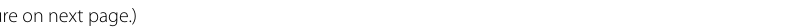
figure on next Fig. 6 Duplication of Chr2-6 and Chr11-2 regions and checking transformants by colony PCR. Upper part of a , b represents 2 duplication modules (One module synthesized from the plasmid pSJ23 contained URA3 and another module synthesized from the plasmid p3121 contained CEN4 as a centromere) were introduced into SJY4 to duplicate Chr2-6 and Chr11-2 regions, separately. Bottom part of a , b represents gel electrophoresis of colony PCR and each lane represents independent transformants without the most left lane, which contains size marker. In a , SJP 550 and SJP 690 were used to check URA3 harboring DNA module whereas SJP 694 and SJP 697 were used to check CEN4 harboring DNA module for the duplication of Chr2-6 region, respectively. In b , SJP 692 and SJP 550 were used to check URA3 harboring DNA module whereas SJP 697 and SJP 696 were used to check CEN4 harboring DNA module for the duplication of Chr11-2 region,